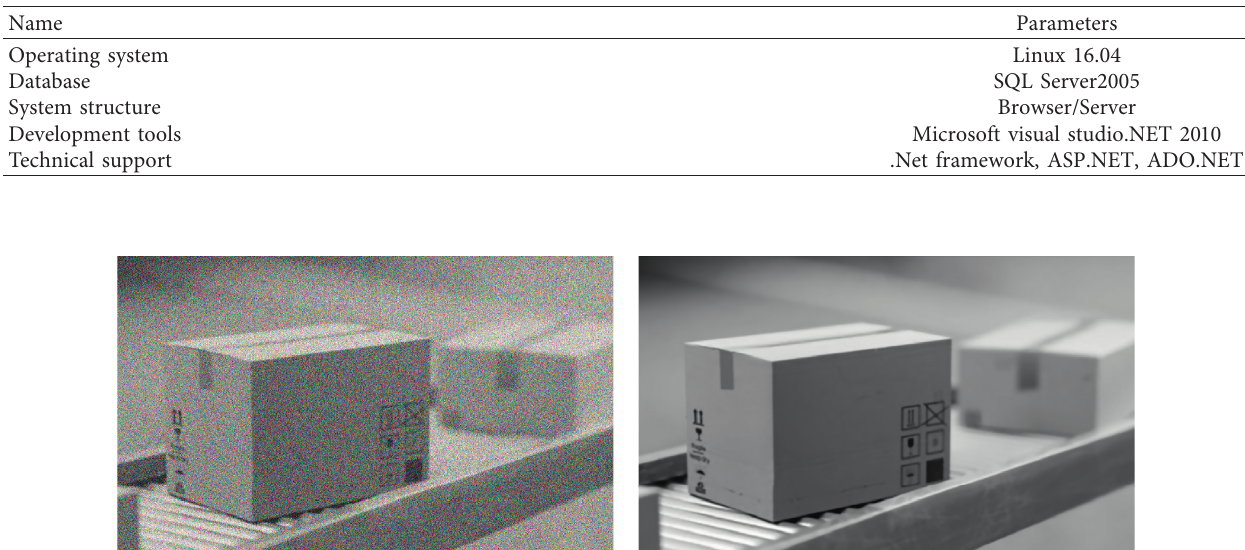
Table 1: Parameters of the intelligent logistics distribution management system.